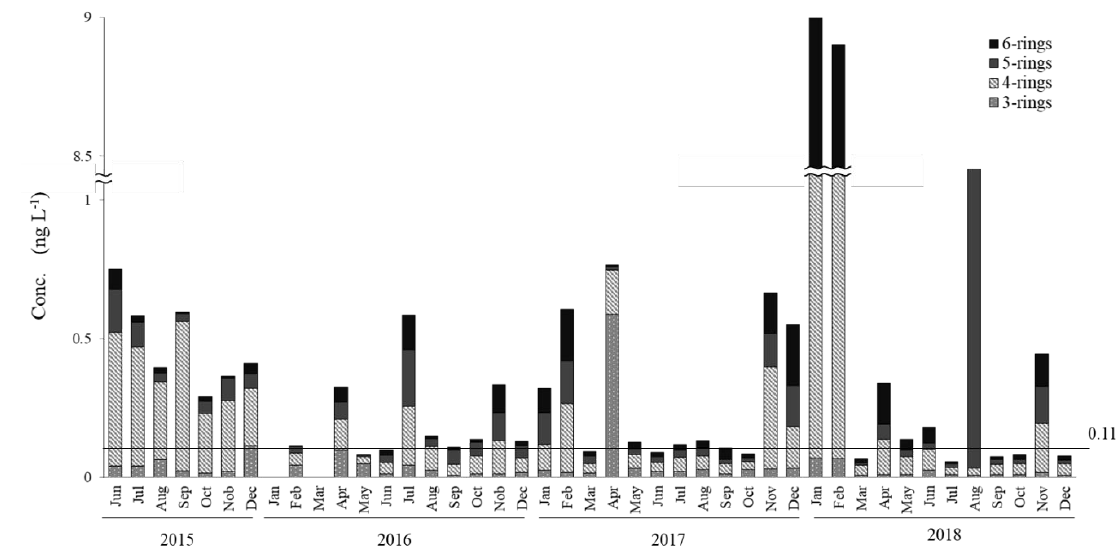
Figure 3. Monthly variations in concentrations of three-ring to six-ring PAHs in the particulate phase in surface seawater in North Nanao Bay during 2015–2018. Table 1. Total concentrations of 13 PAHs (ng · L − 1 ) in surface seawater from di ff erent locations